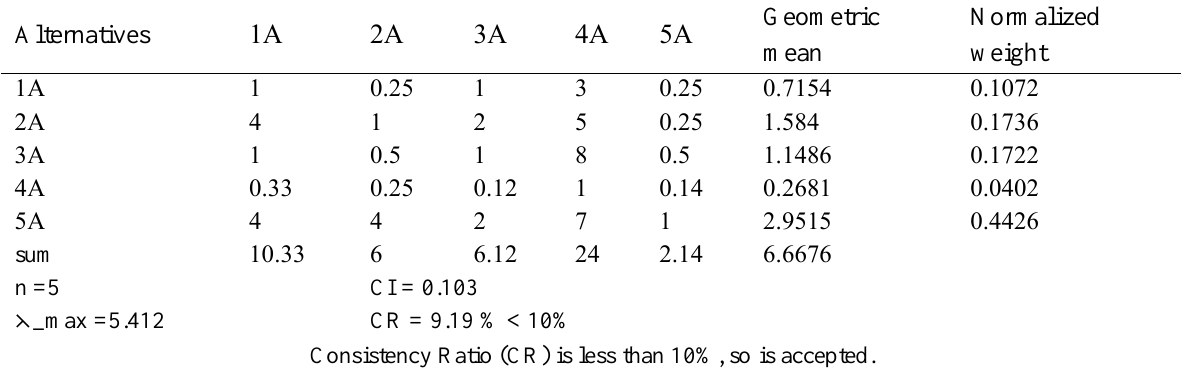
Table 9. Comparison Matrix of Alternatives with respect to C5.